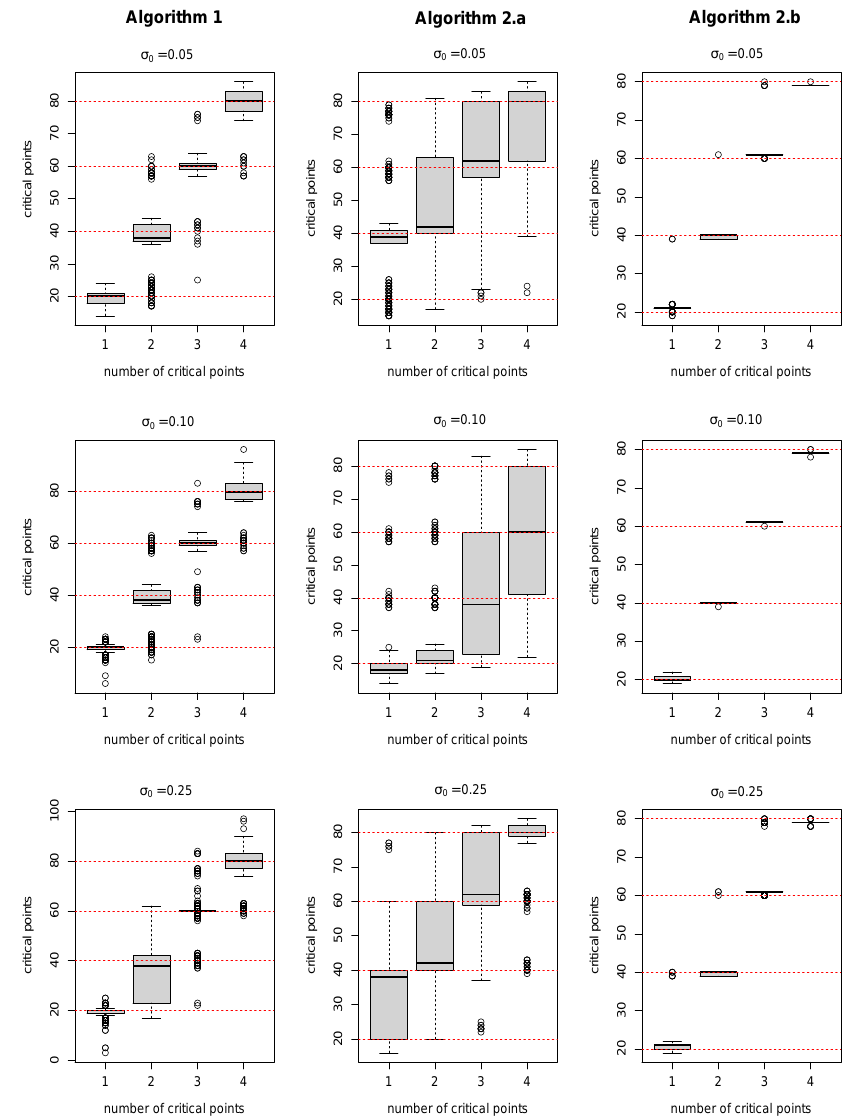
Figure 2. Boxplots of the estimated critical scales together with the theoretical scales (red lines) for σ 0 = 0.05 (top), σ 0 = 0.10 ( middle ) and σ 0 = 0.25 ( bottom ) under Algorithm 1 ( left ), Algorithm 2.a ( middle ) and Algorithm 2.b ( right